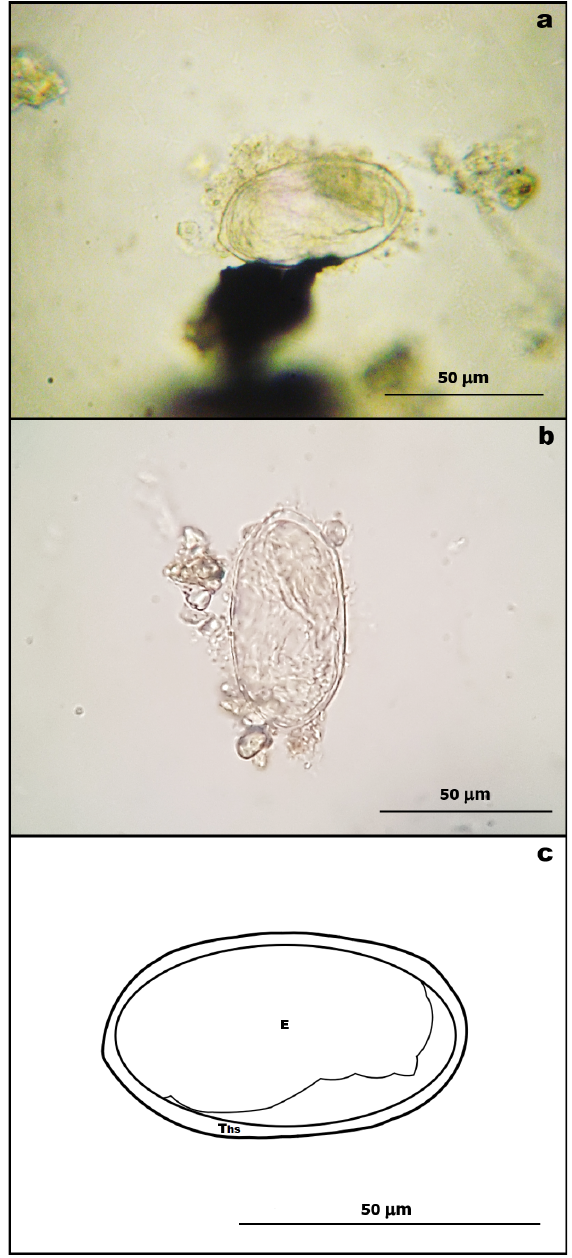
Figure 3. Strongylida ovoidal eggs (probably Ancylostomatidae) recovered in coprolite assigned to Carnivora mammal from the Milton Almeida Outcrop, Touro Passo Formation (Upper Pleistocene), Municipality of Uruguaiana, Western region of State of Rio Grande do Sul, Southern Brazil (400 X magnification). a-b. Photomicrographs; c. Representative drawing. Abbreviations: Ths = thin hyaline shell; E =